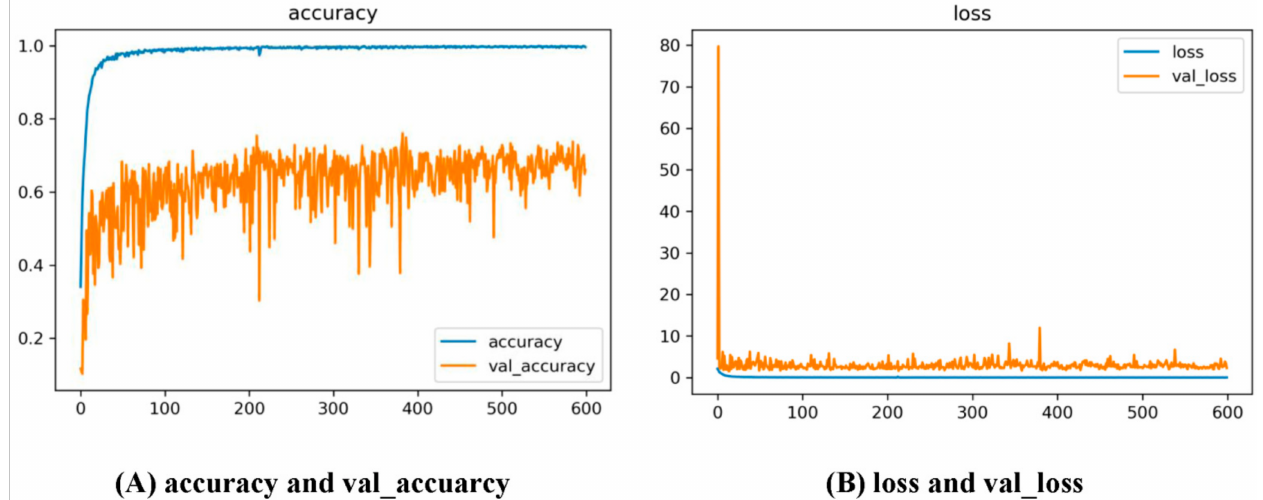
Figure 8. Training accuracy ( A ) and loss ( B ) curves of the proposed dual CNN method with epoch = 600 and five-fold cross-validation.